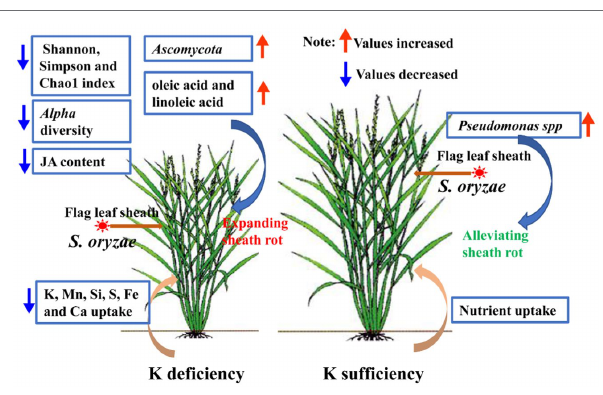
FIGURE 8 | Summary model. S. oryzae infection alters the metabolism process, which reflected as the accumulation of oleic acid and linoleic acid in flag leaf sheath. K starvation promoted S. oryzae infection and linoleic acid accumulation. In turn, the alterations in metabolites of host plant affect the growth of endophyte communities. Meanwhile, due to the linoleic acid is the precursor for JA synthesis, hyper-accumulation of linoleic acid in leaf sheath causes the decreasing in JA content. JA mediated the nutrients uptake process, especially for K + uptake; thus, the low level of JA further inhibited the nutrients uptake of host plant. Finally, K-starvation aggravates S. oryzae infection and ultimately leads to alterations in endophyte communities and suppression of nutrient